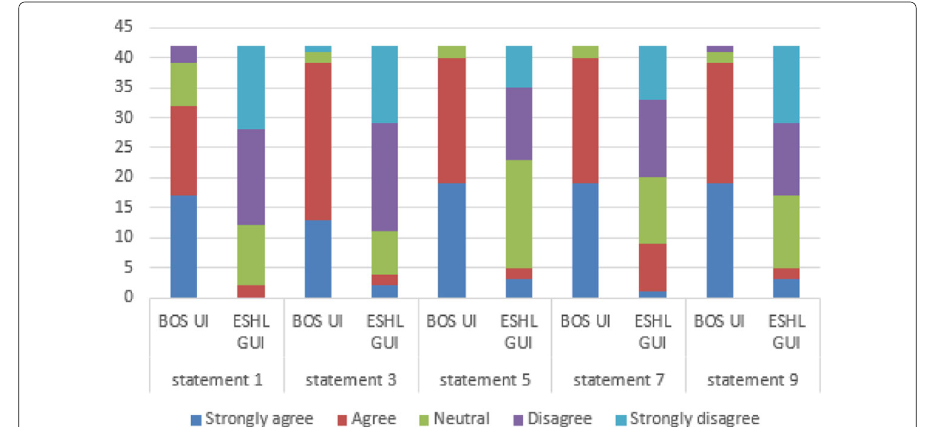
Fig. 38 Stacked bar chart of the participants’ answer to the odd numbered statements in the SUS questionnaire about the BOS UI and ESHL GUI